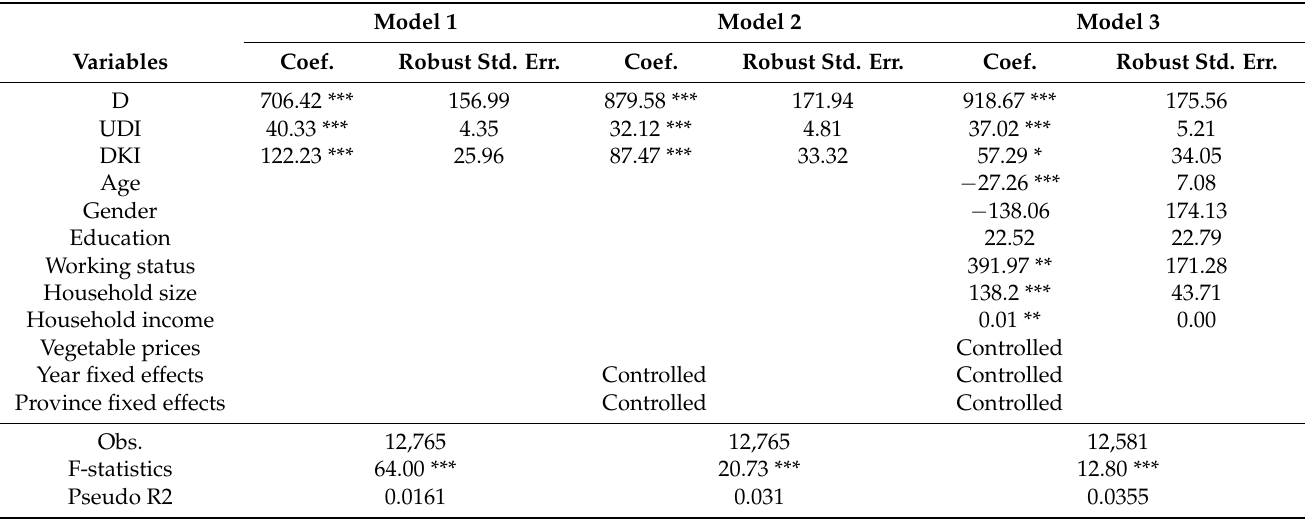
Table 4. Estimation results on